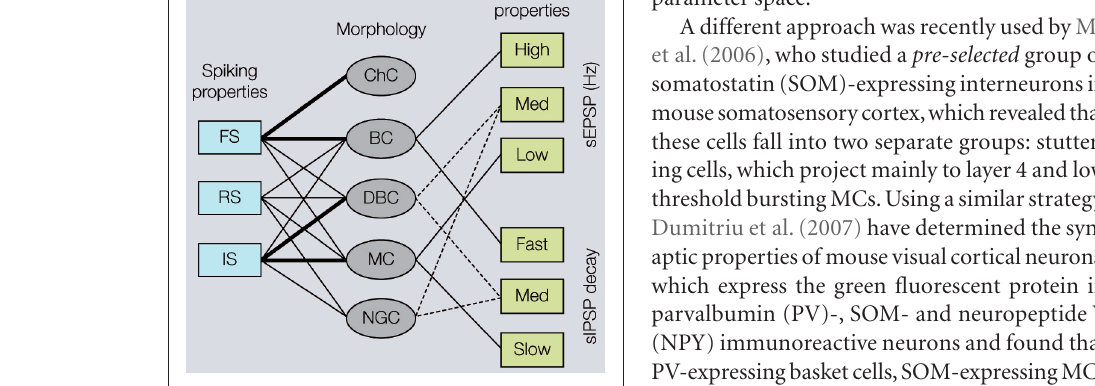
Figure 2 | Associations of electrophysiological and morphological properties of interneurons based on cluster analyses. Left side: Fast spiking (FS) properties (i.e., narrow action potentials, non-accommodating) are strongly linked (indicated by thick lines) to chandelier cells (ChC) and basket cells (BC). Relatively few (indicated by thin lines) interneurons show regular spiking (RS) properties (i.e., broad action potentials, accommodating), which are typically found in pyramidal cells. Intermediate spiking (IS) properties (i.e., narrow action potentials, accommodating) are strongly associated with interneurons that have vertically oriented axons (e.g., double bouquet cells (DBC) and Martinotti cells (MC)). Neurogliaform cells (NGC) never express FS properties. Right side: BCs receive high amplitude spontaneous excitatory postsynaptic potentials (sEPSP) and generate fast decaying spontaneous inhibitory postsynaptic potentials (sIPSPs). Putative DBCs and/or NGCs receive medium amplitude sEPSPs and more slowly decaying sIPSPs. Notice, because the cells have only been identified by the absence of BC and MC morphologies, the associations are indicated by dashed lines. MCs receive low amplitude sEPSPs and generate slowly decaying